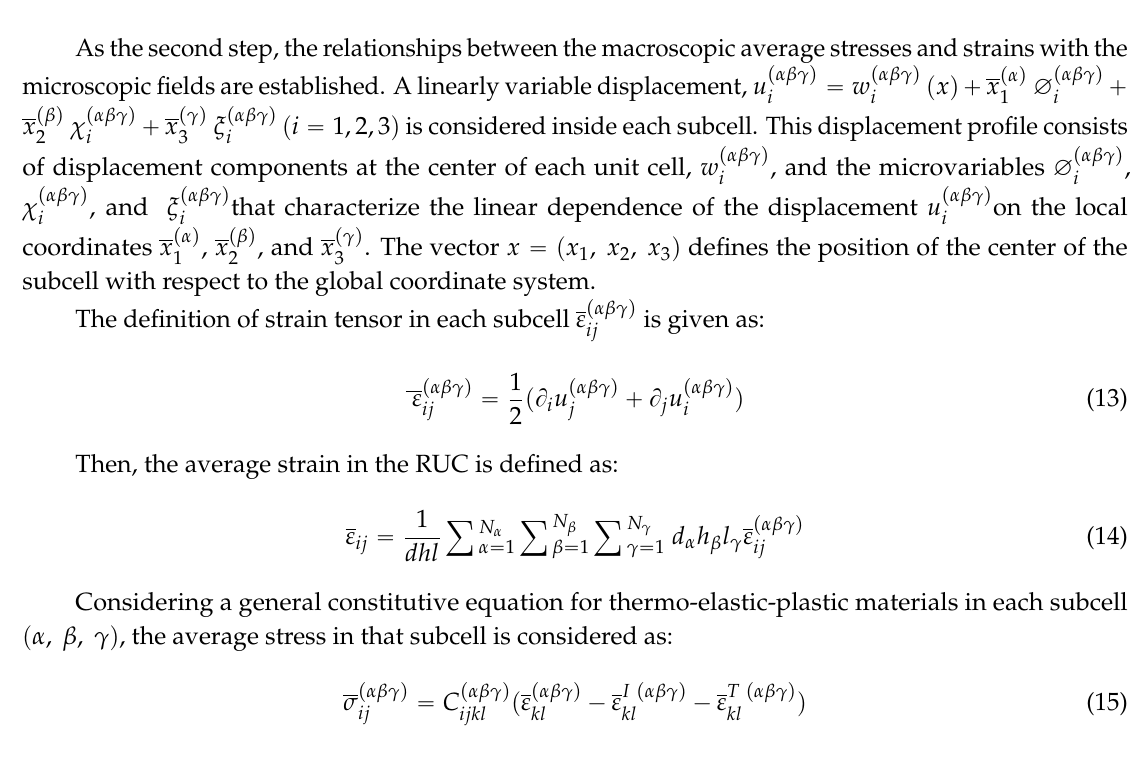
Figure 1. ( a ) Repeating Unit Cells (RUCs); ( b ) A sample RUC discretization consisting of (cid:1840) (cid:3080) = 3 , (cid:1840) (cid:3081) = 4 and (cid:1840) (cid:3082) = 2 subcells.